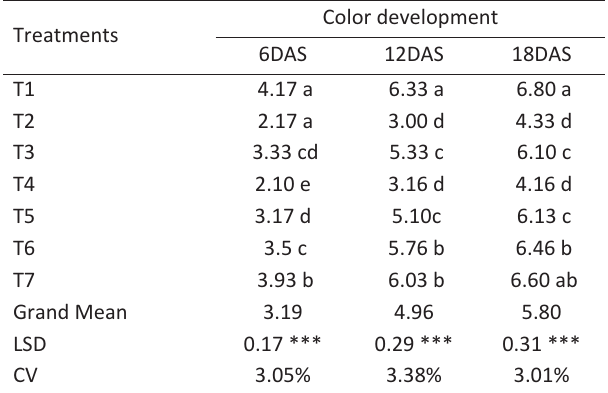
Means in the column followed by similar letters are not statisti­ cally different at p=0.05 by